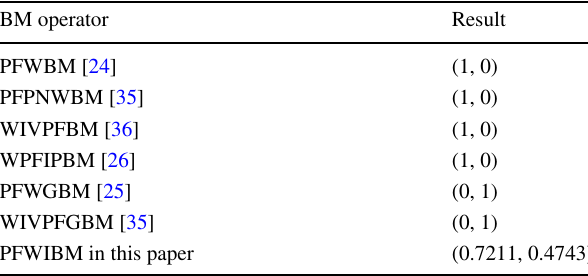
Table 13 Aggregation results of different Pythagorean fuzzy BM operators BM operator